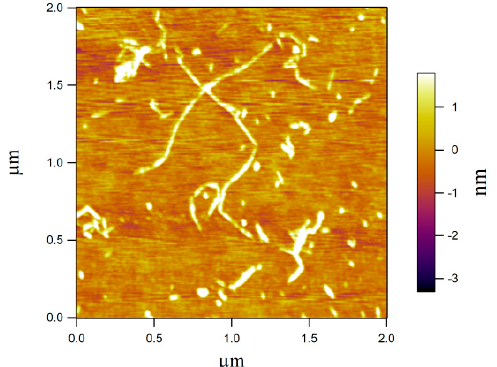
Figure 2. Dimension of CNFs determined using the AFM.